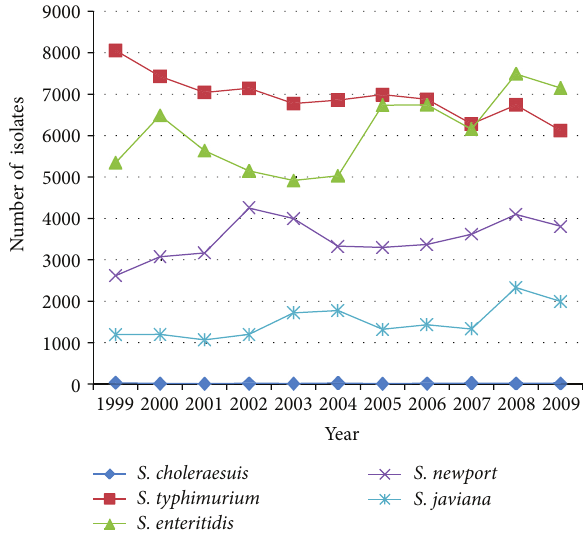
Figure 1: Laboratory-confirmed Salmonella isolates from human sources reported to CDC by serotype and year, 1999–2009; com- paring the number of S. choleraesuis isolates to the most frequently reported